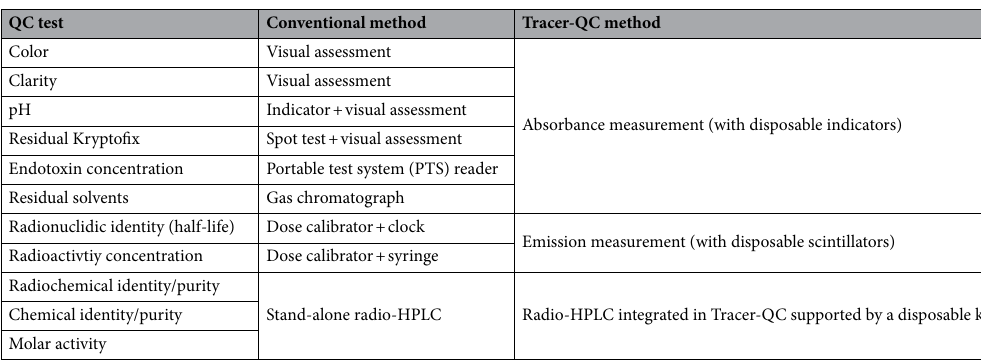
Table 2. Comparison of conventional and automated methods of [ 18 F]FBB quality control